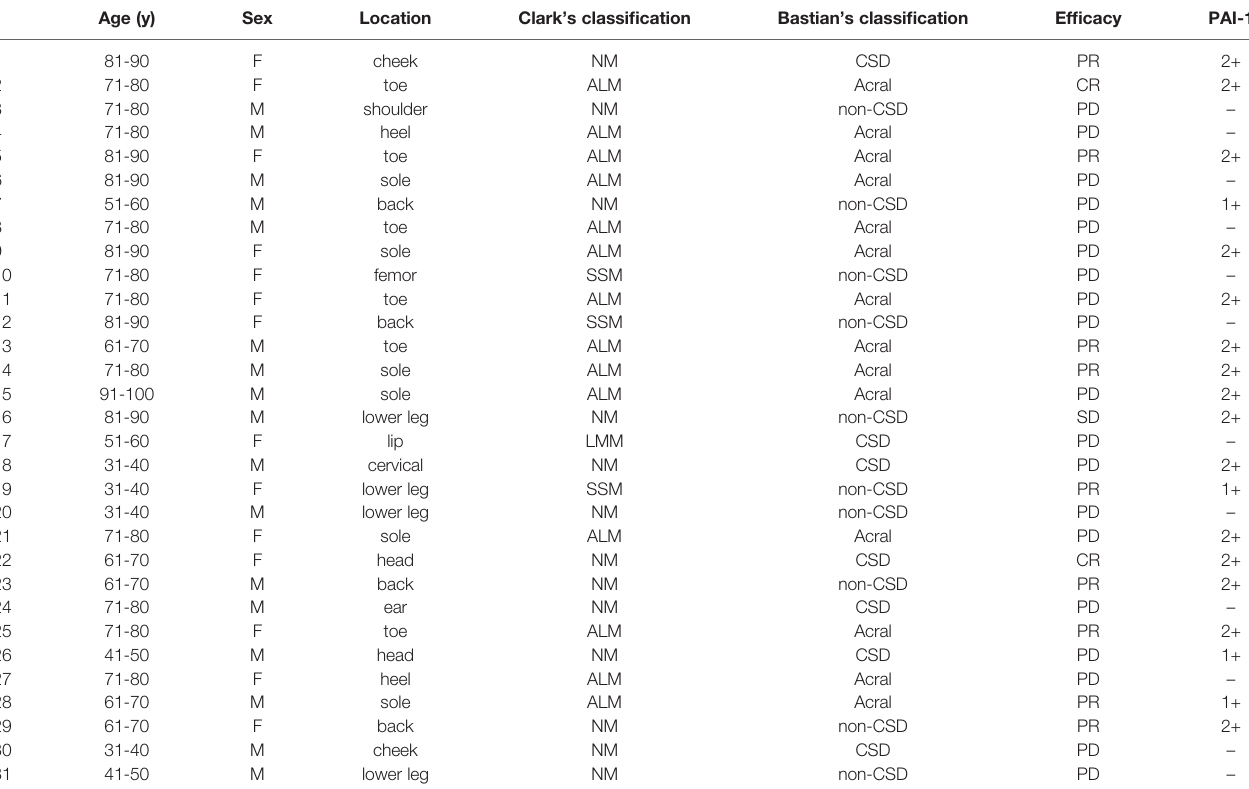
TABLE 1 | Characteristics and PAI-1 expression levels of 31 patients with advanced